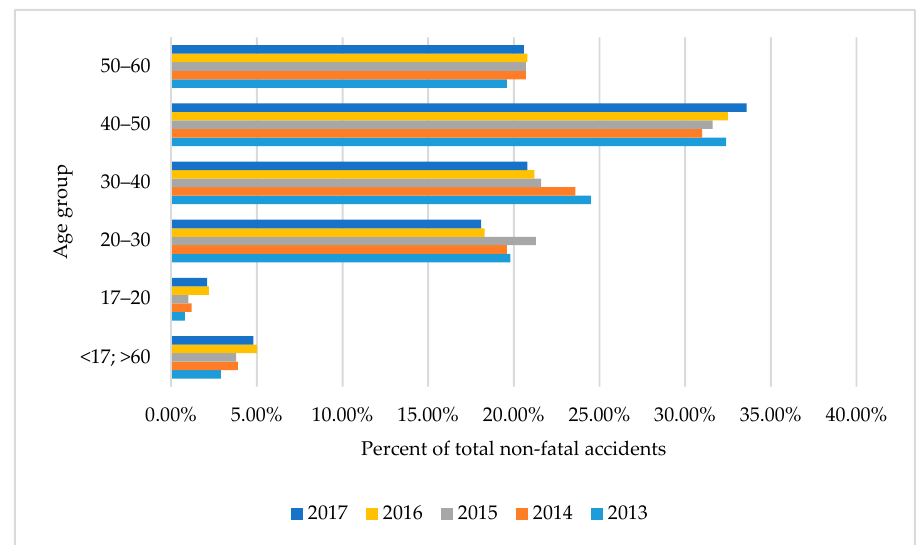
Figure 14. Assessment of non-fatal work accidents by age group [1,2].